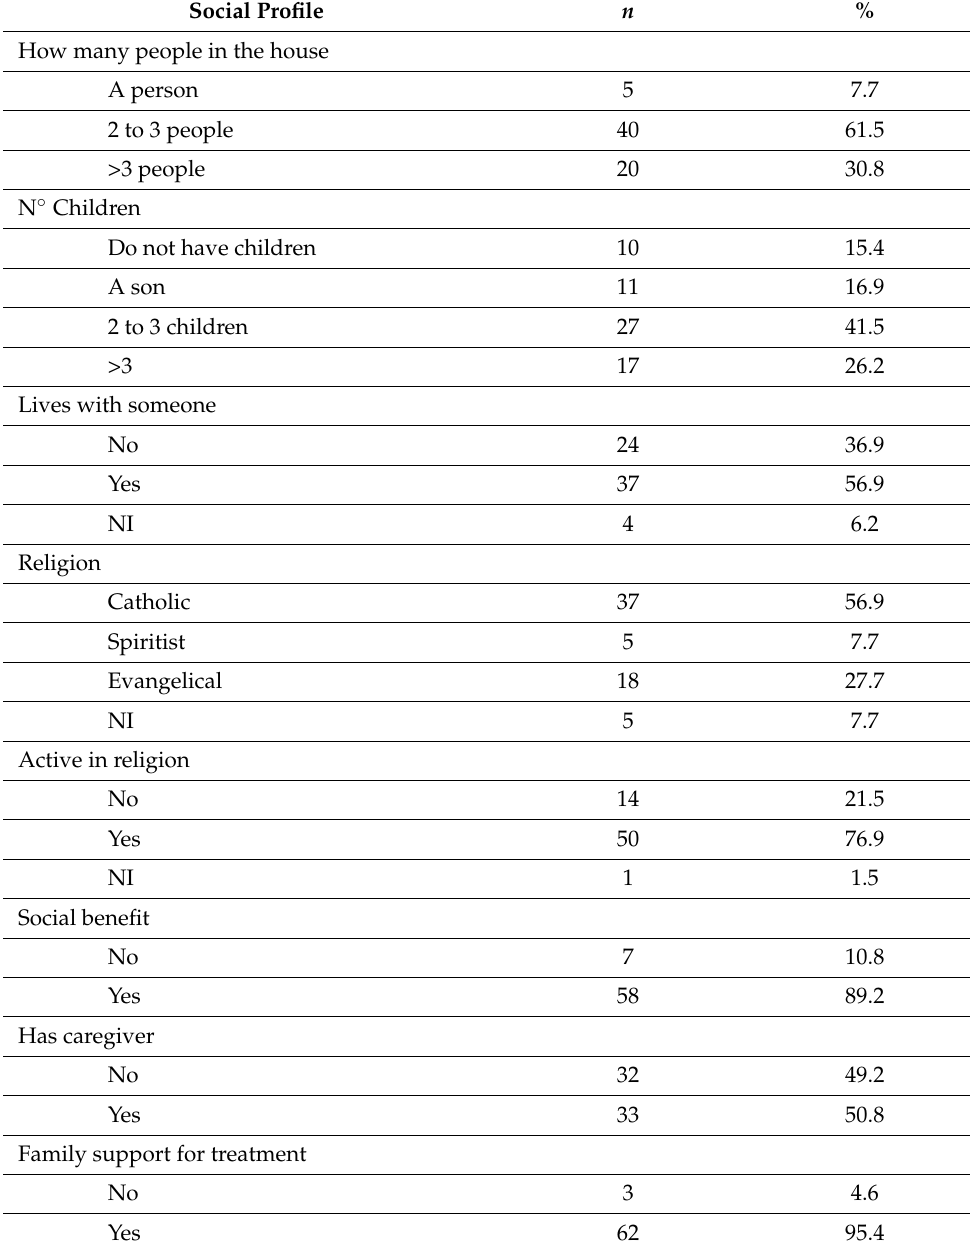
Table 2. Characterization of the social profile ( n =